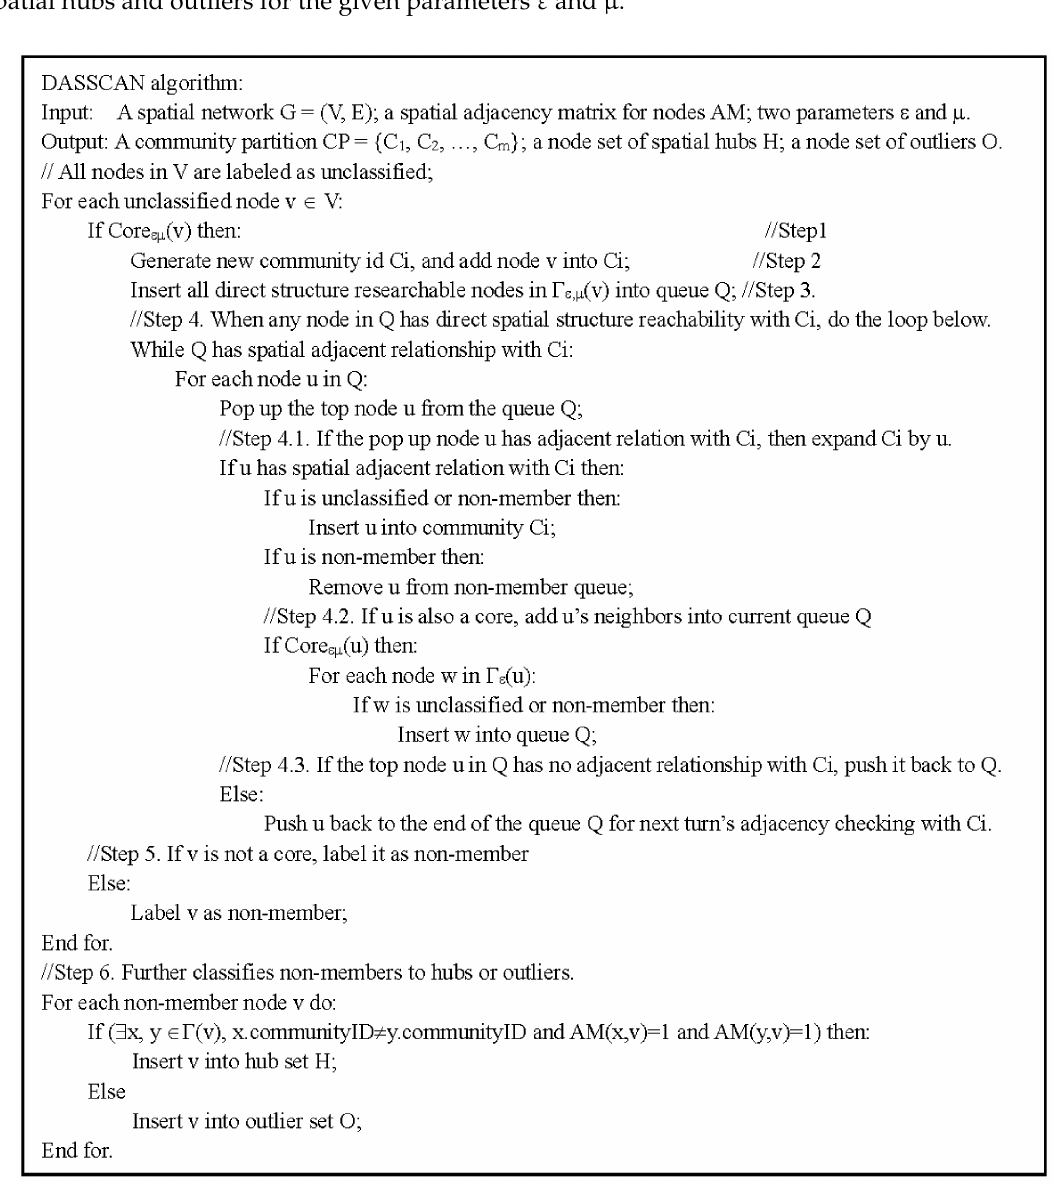
Figure 6. The Pseudo code for the DASSCAN